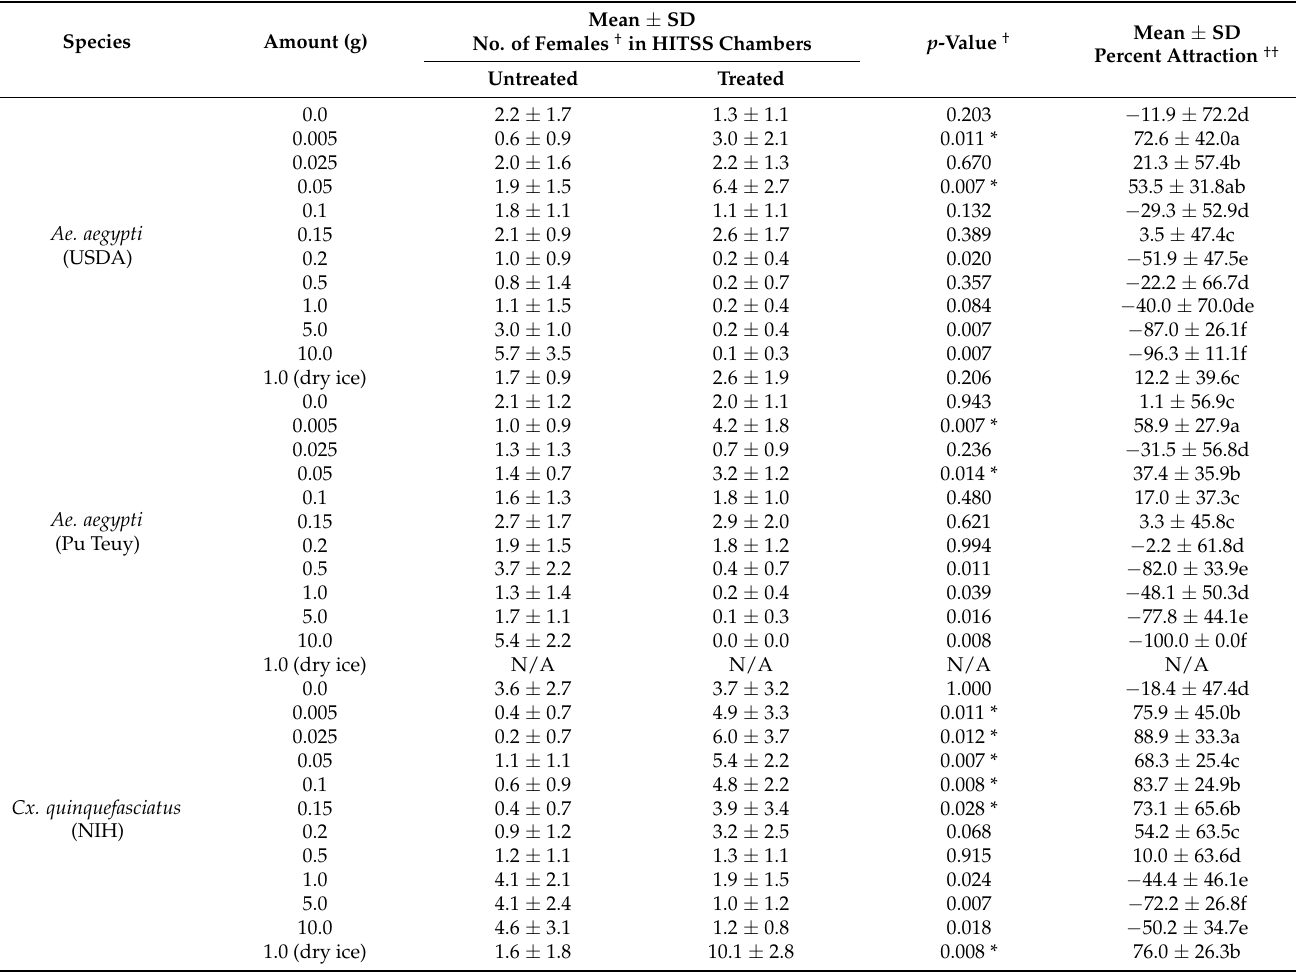
Table 1. Mean ± SD percentage attraction of Aedes aegypti and Culex quinquefasciatus for different doses of BG-lure. Mean ± SD Species Amount (g) No. of Females † in HITSS